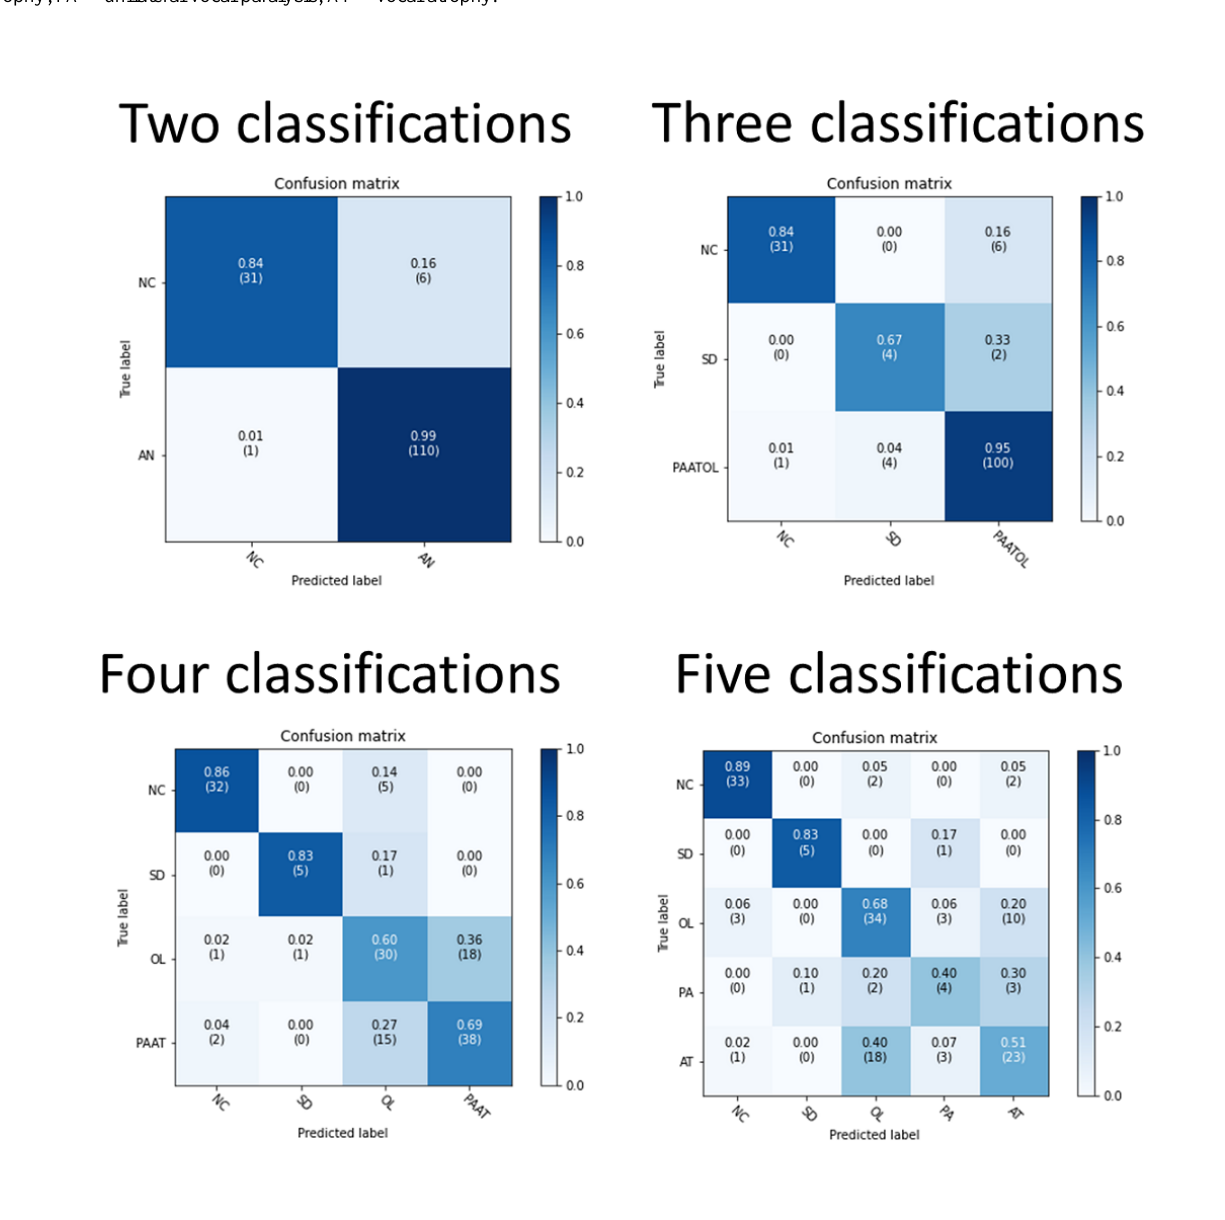
Figure 2. Confusion matrix of 2, 3, 4, and 5 classifications. AN = pathological voice; NC = normal voice; SD = adductor spasmodic dysphonia; PAATOL = unilateral vocal paralysis/vocal atrophy/organic vocal fold lesions; OL = organic vocal fold lesions; PAAT = unilateral vocal paralysis/vocal atrophy; PA = unilateral vocal paralysis; AT = vocal